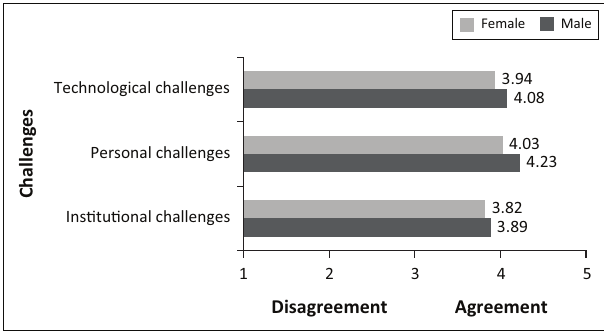
FIGURE 1: An adapted institutional analysis framework.